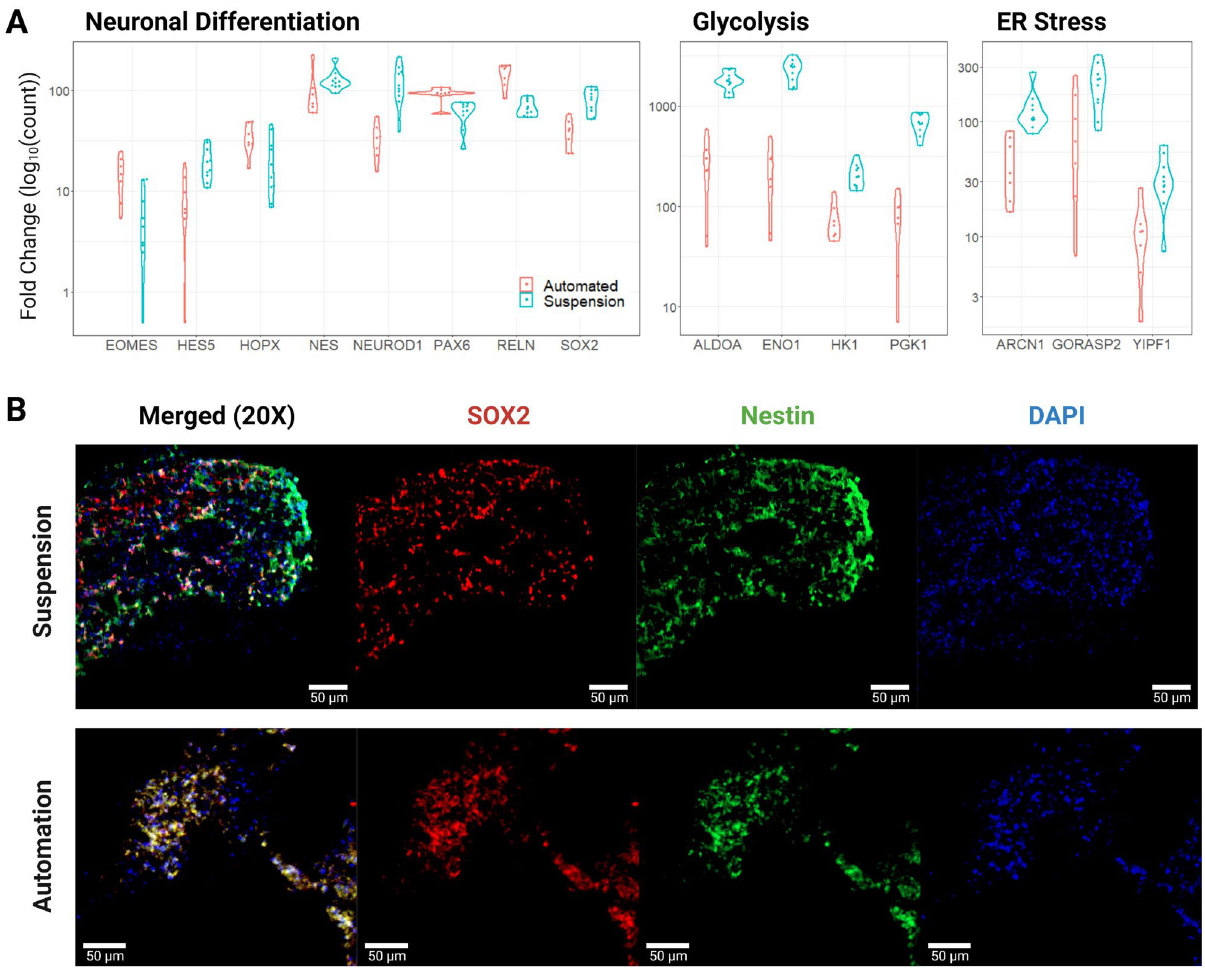
Figure 7. Transcription and immunofluorescent imaging results. ( A ) Pairwise comparisons of expression for select genes associated with neural differentiation, glycolysis, and ER stress. Results were statistically significant with an adjusted p value ≤ 0.05, except for HOPX and NES of neural differentiation. The “Automated” data represent 7 biological replicates and the “Suspension” data represent 4 biological replicates with 6 technical replicates ( B ) Immunofluorescent stains for SOX2, Nestin, and DAPI of Suspension and Automated organoid sections show congruent progenitor